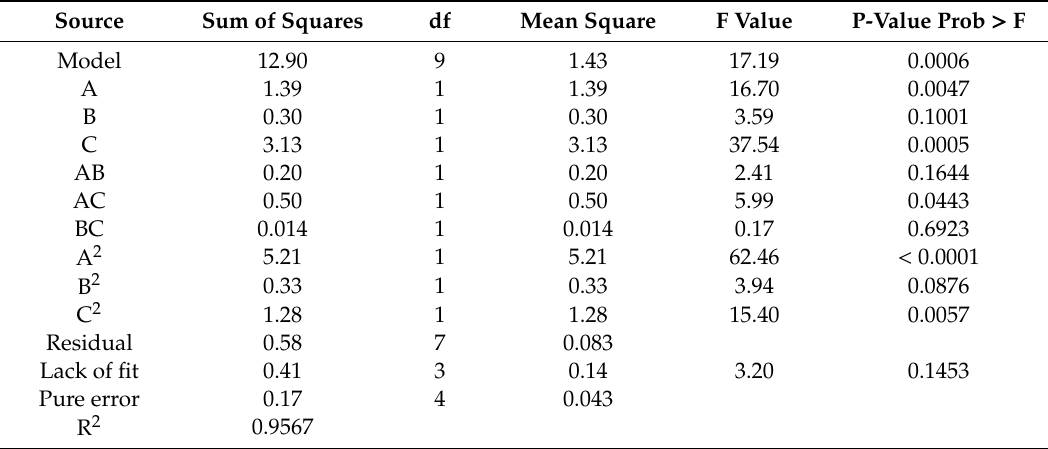
Table 2. Analysis of variance for regression model